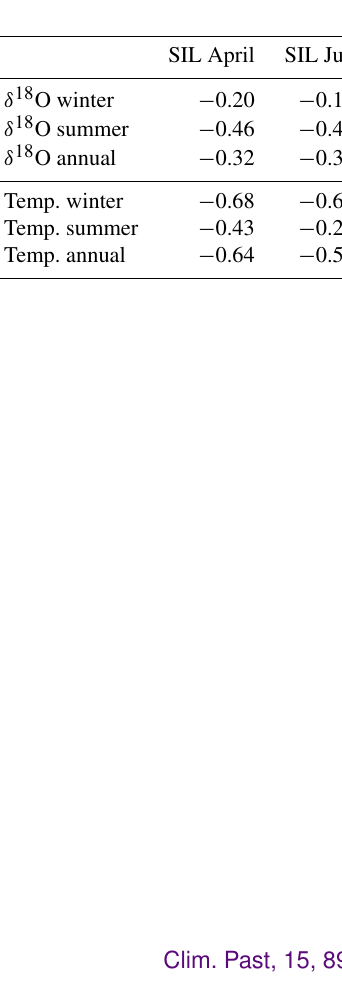
Table C1. Correlation coefficients for different combinations of sea ice line anomalies (SIL) versus Stykkishólmur temperature and δ 18 O for the period 1850–2000. The time series were first smoothed with a 5-year moving average. All the correlations are significant ( p < 0 .